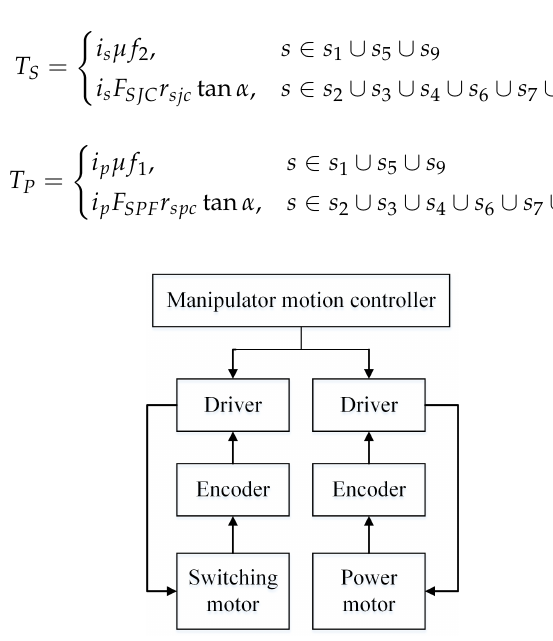
Figure 23. Illustration of the manipulator control